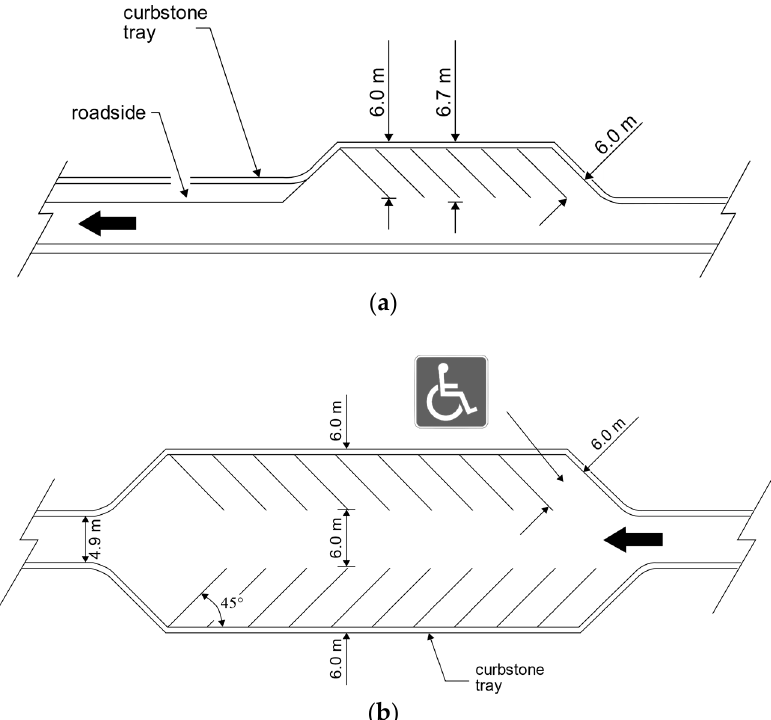
Figure 1. Schemes of planning of parking spaces for passenger cars with one-sided ( a ) and two-sided ( b ) placement in the USA.